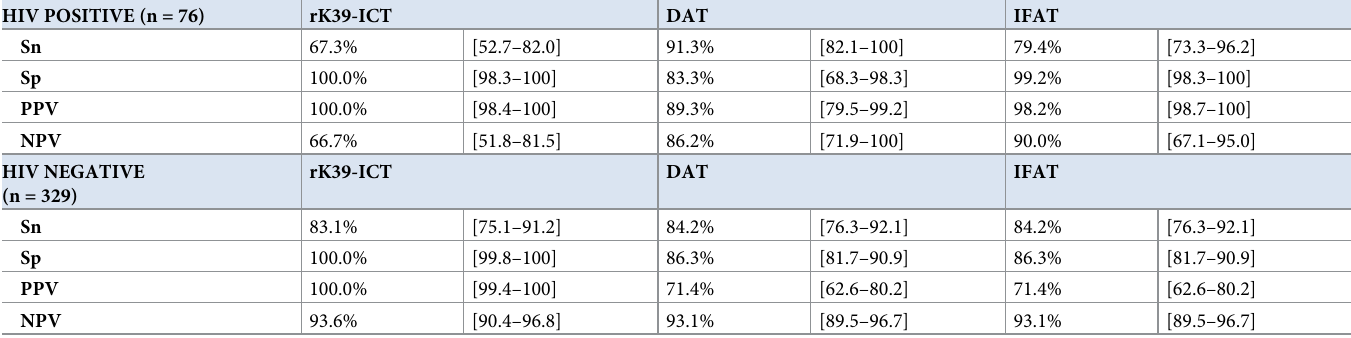
Table 3. Sub group analysis on HIV status. Performance of rK39, DAT and IFAT on suspected visceral leishmaniasis samples in Spain, 2010–2014. Sensitivity (Sn), spec- ificity (Sp), positive predictive value (PPV), negative predictive value (NPV) with 95% confidence intervals []. HIV POSITIVE (n =